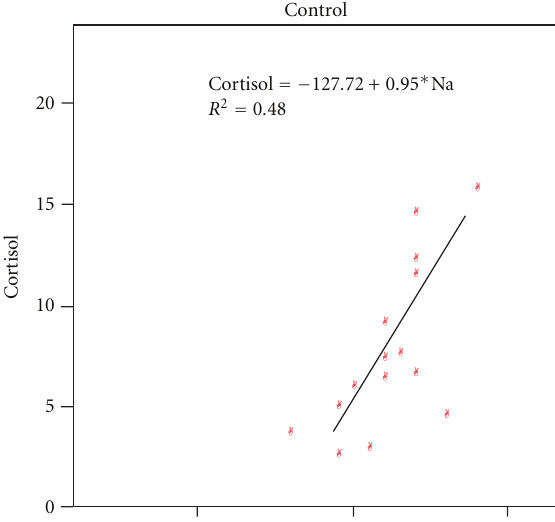
Figure 1: Correlation between sodium (Na + ) and